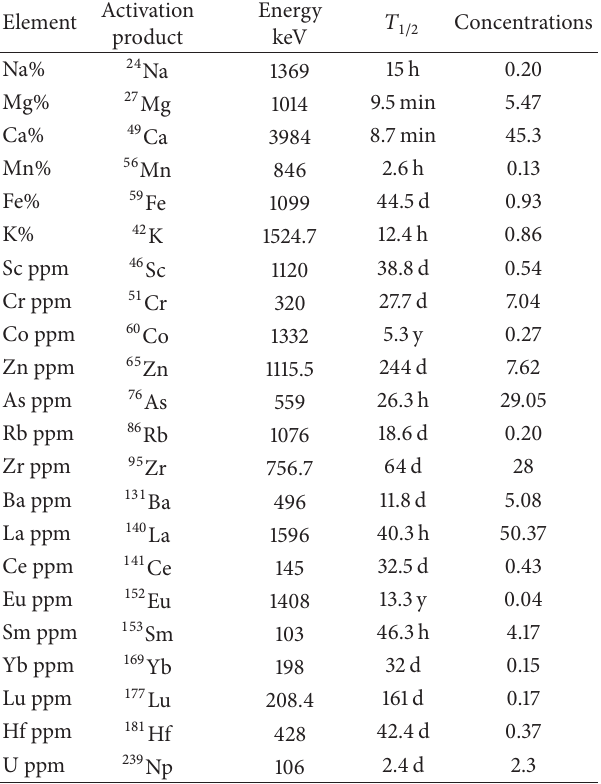
Table 2: The nuclear data and the average concentrations of ele- ments determined in